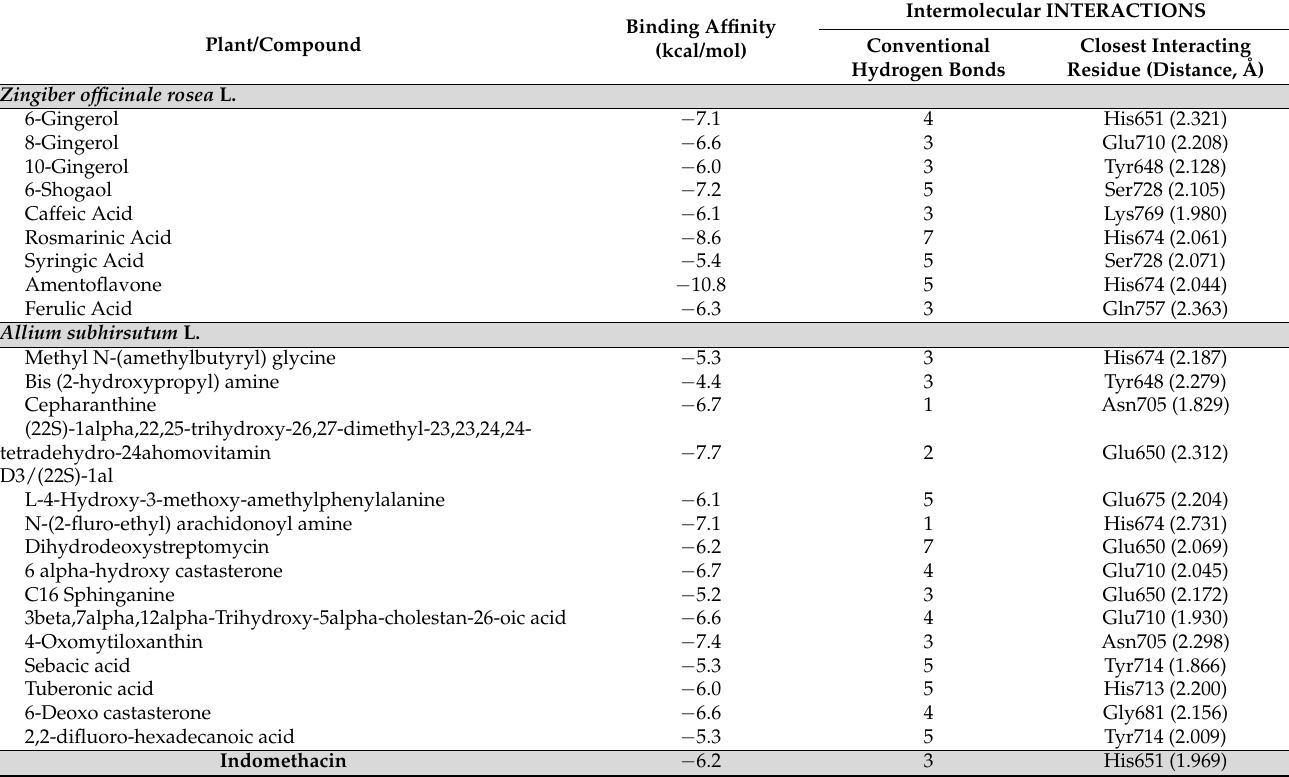
Table 4. Ligands and human toll-like receptor 6 (TLR6) interactions: binding affinity, number of conventional hydrogen bonds and distance to the closest interacting residue.